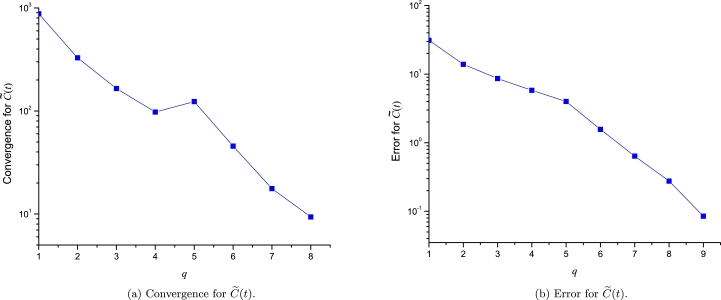
Convergence and error analysis for C˜(t).